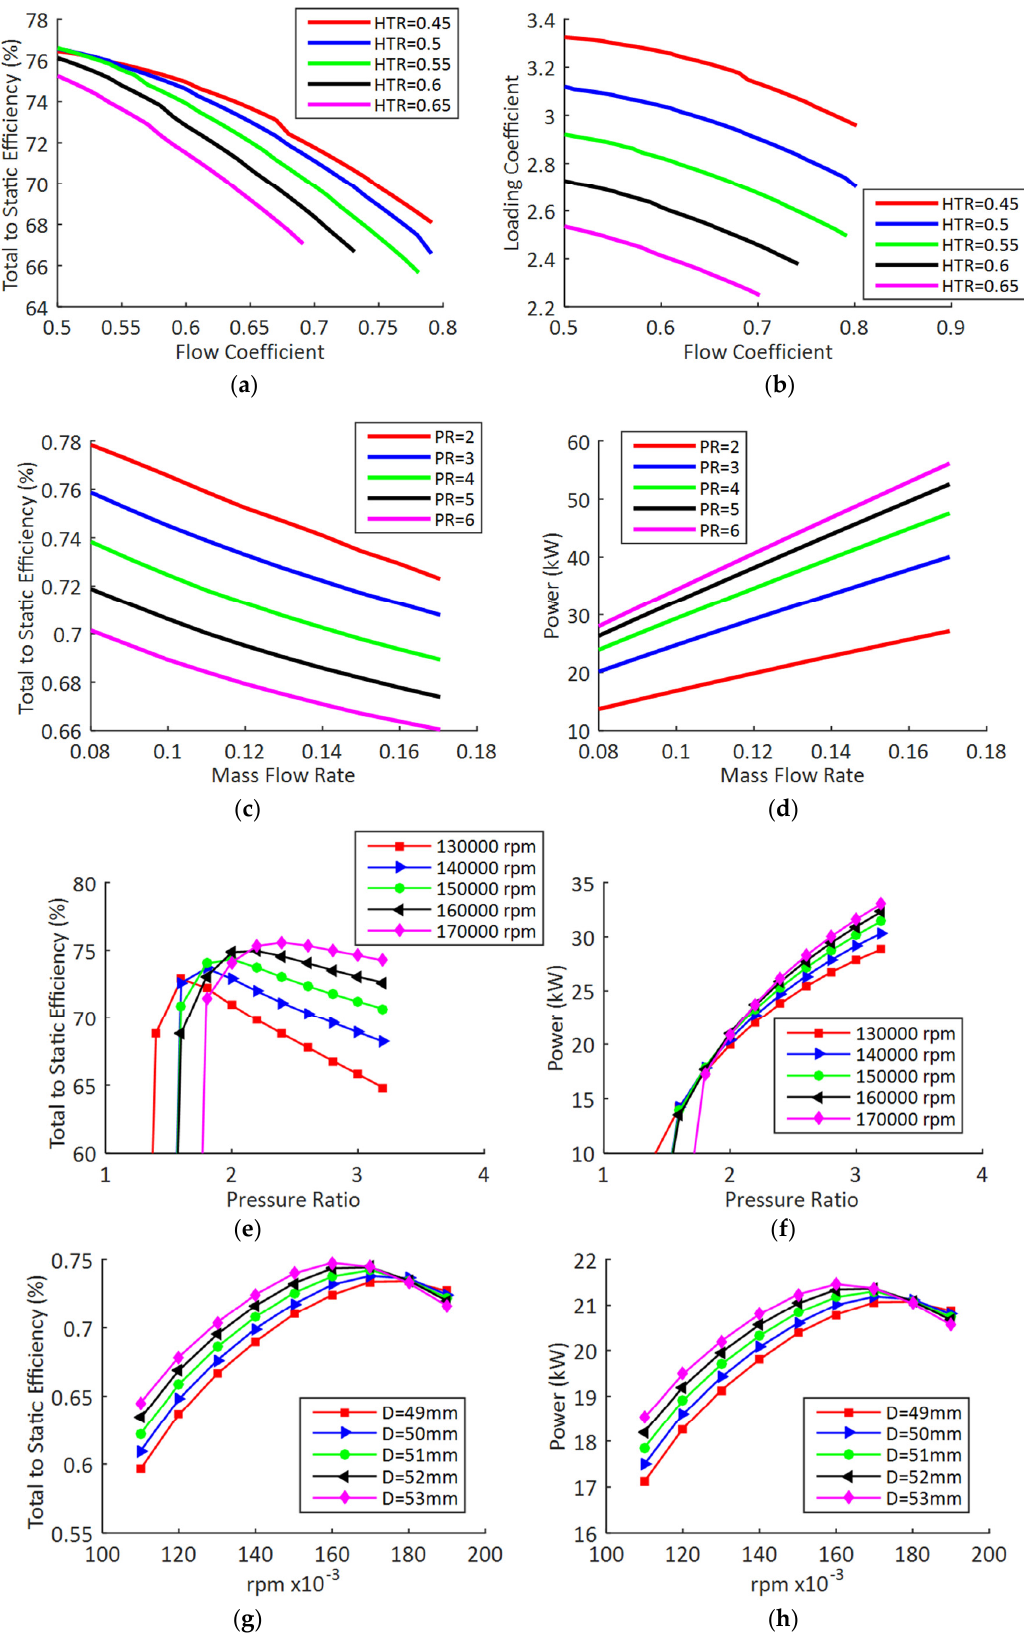
Figure 8. MATLAB predicted effect of flow coefficient ( a , b ), mass flow rate ( c , d ), pressure ratio ( e , f ), and shaft speed ( g , h ) on turbine total to static efficiency ( a , c , e , g ) and turbine power ( b , d , f , h ).